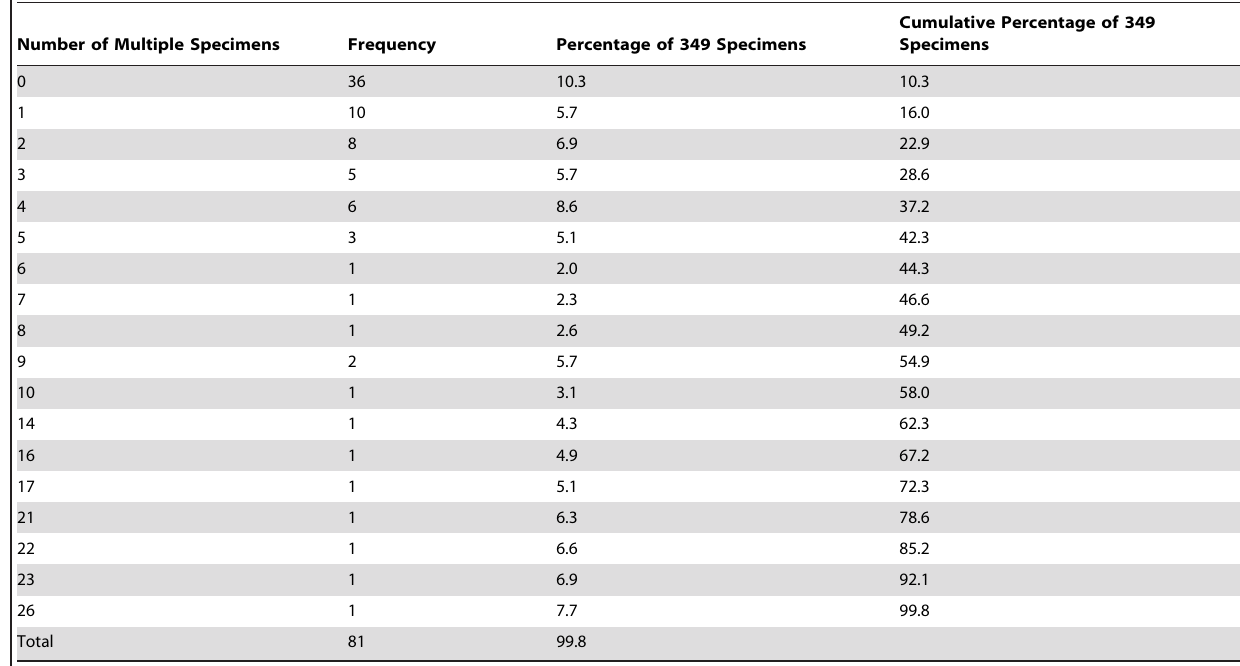
Table 3. Frequency and percentage of classes that have multiple